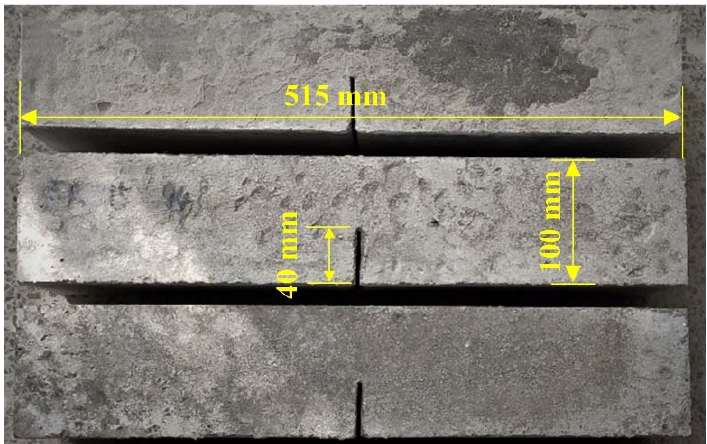
Figure 1. Concrete prisms with pre ‐ notch.